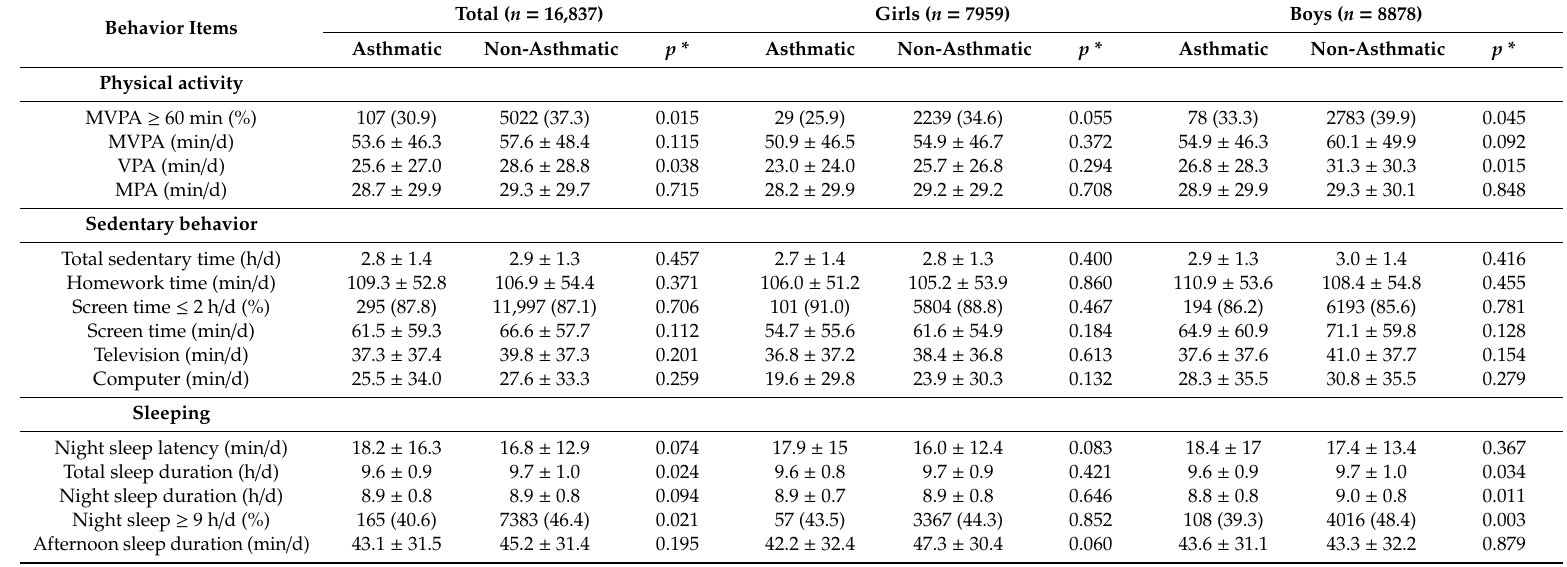
Table 2. Di ff erences in lifestyle factors between children with and without physician-diagnosed